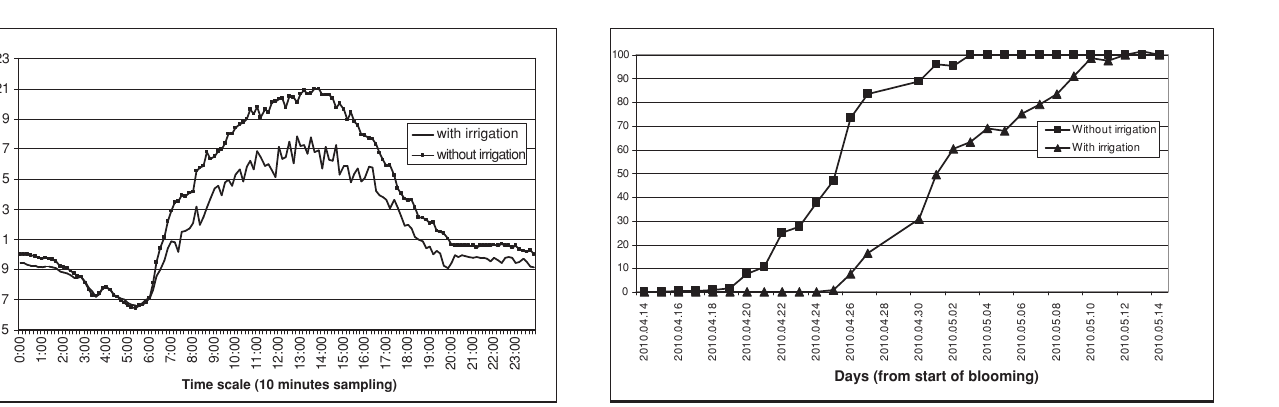
Figure 5: The effect of daytime irrigation on the daily distribution of temperature in apple plantation on a windy day when the average wind speed was higher than 10m/s. 29th of April 2010 (Figure 6). By usage of micro sprinklers the bud surface showed a decreasing of relatively high temperature (2–2,5 °C) within short intervals. 5791113151719212325 Figure 6: The effect of daytime irrigation on the daily distribution of temperature on the day, when the wind speed was lower than 3m/s, and the relativehumiditylessthan50%atnoon-inappleplantation.23rdofApril2010.